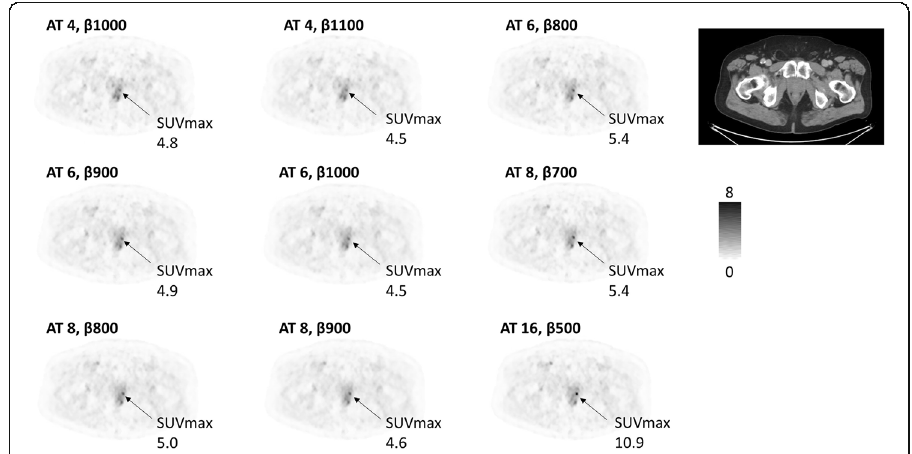
Fig. 4 Example of images with different AT and different β values. An uptake in the prostate is indicated, and the SUVmax